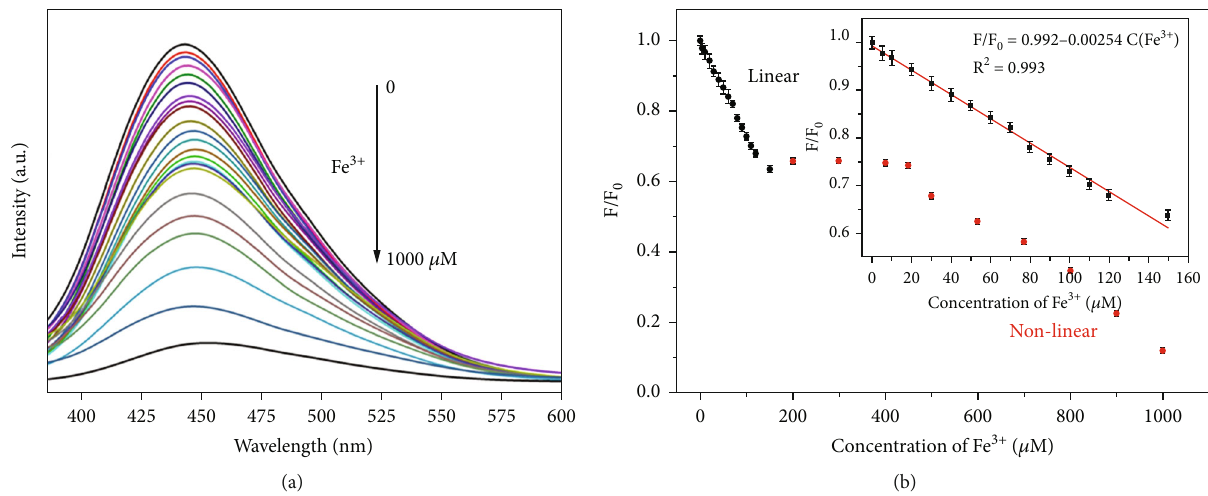
Figure 8: (a) Fluorescence emission spectra of the CQDsHG upon exposure to various concentrations of Fe 3+ solutions (from top to bottom: 0, 5, 10, 20, 30, 40, 50, 60, 70, 80, 90, 100, 110, 120, and 150 μ M) under excitation at 370nm and (b) the calibration curves and linear equation for the fl uorescence quenching ratio and concentration of Fe 3+ . Table 2: Comparison of the probes for the detection of Fe 3+ ions.